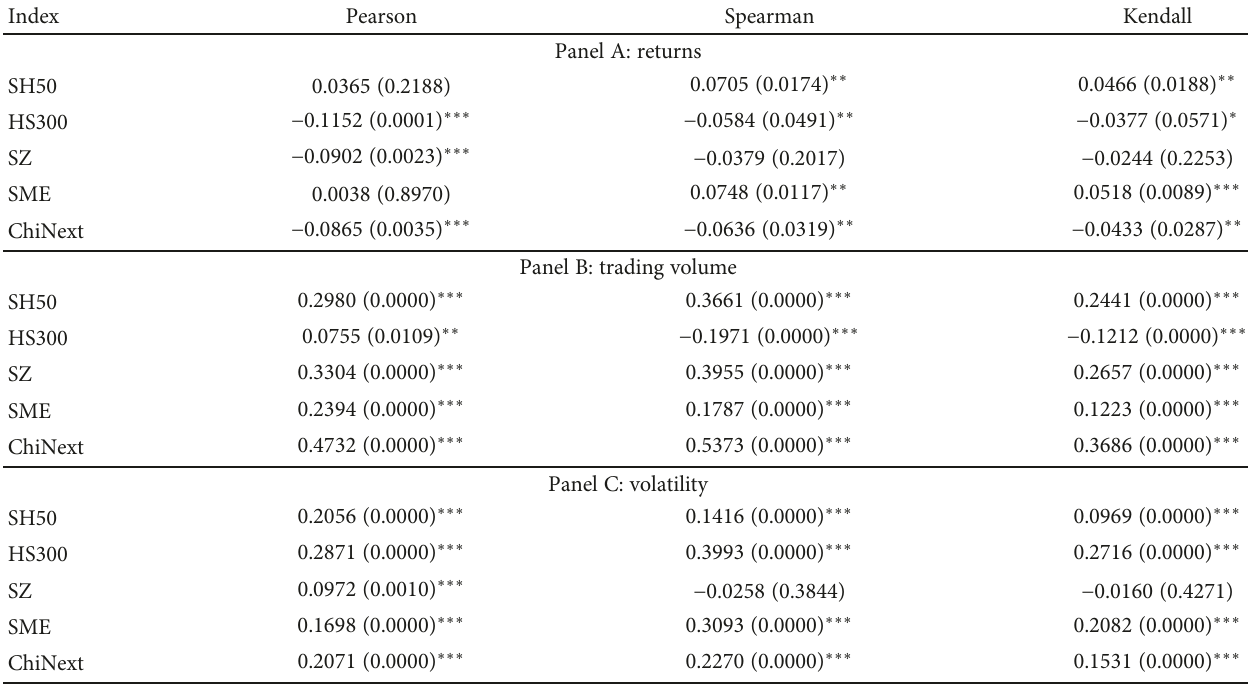
Table 2: Correlation coe ffi cients between Weibo Index and market